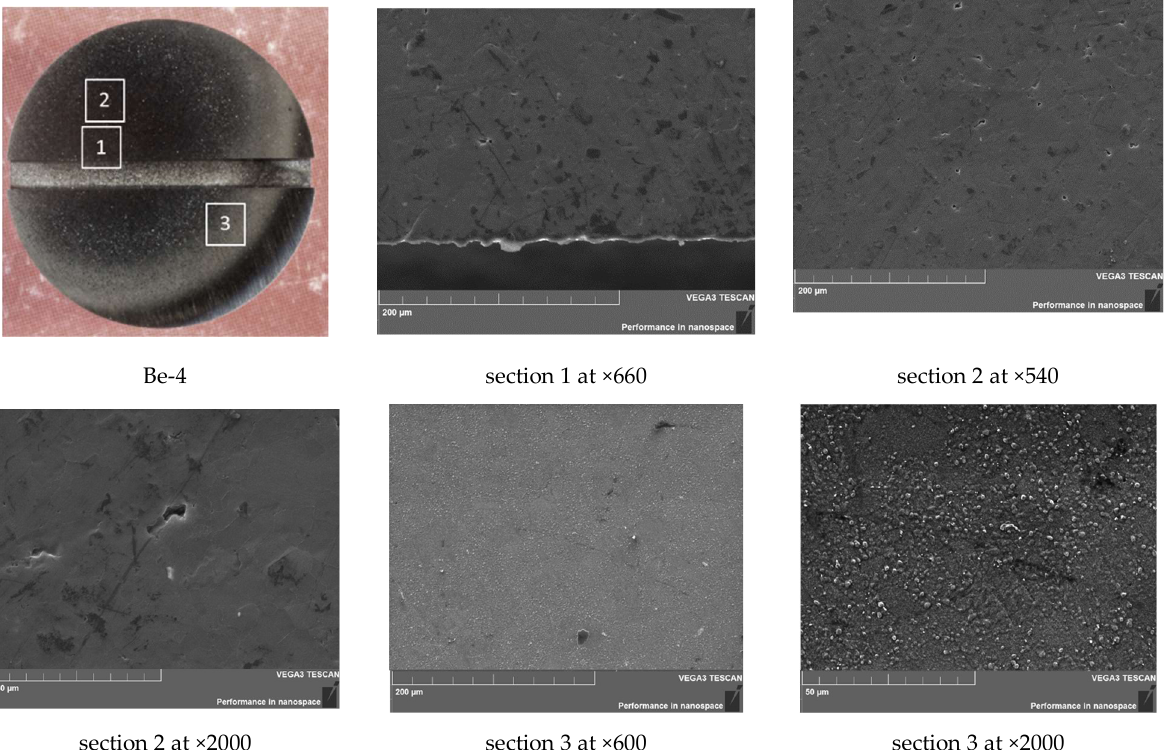
Figure 7. SEM images of the sample Be-4 surface (360 °С, 100